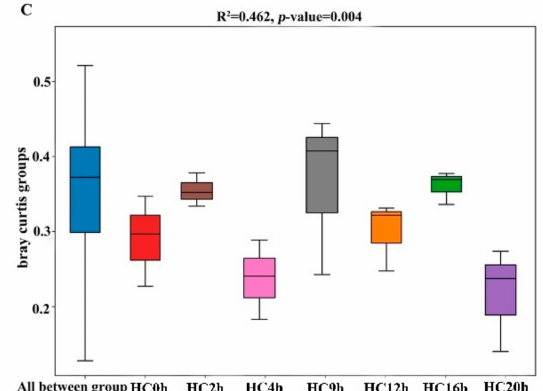
Figure 3. Box plot of inter-group and intra-group beta distance (ANOSIM analysis). ( A ) Beta distance of HF and HC groups. ( B ) Beta distance of HF dietary group. ( C ) Beta distance of HC dietary group. The x -axis represents the grouping, and the y -axis represents the distance calculated by bray_curtis. The data in the box is the distances of the inter-group and intra-group, respectively. R-value: R-value range( − 1,1). TheR-value ≤ 0representsnosignificantdi ff erencesoftheinter-groupandintra-group, and R-value > 0 shows that inter-group di ff erences are greater than intra-group di ff erences. Boxes represent theinterquartilerange(IQR)betweenthefirstandthirdquartiles(25thand75thpercentiles, respectively), and the horizontal line inside the box defines the median. Whiskers represent the lowest and highest values within 1.5 times the IQR from the first and third quartiles,